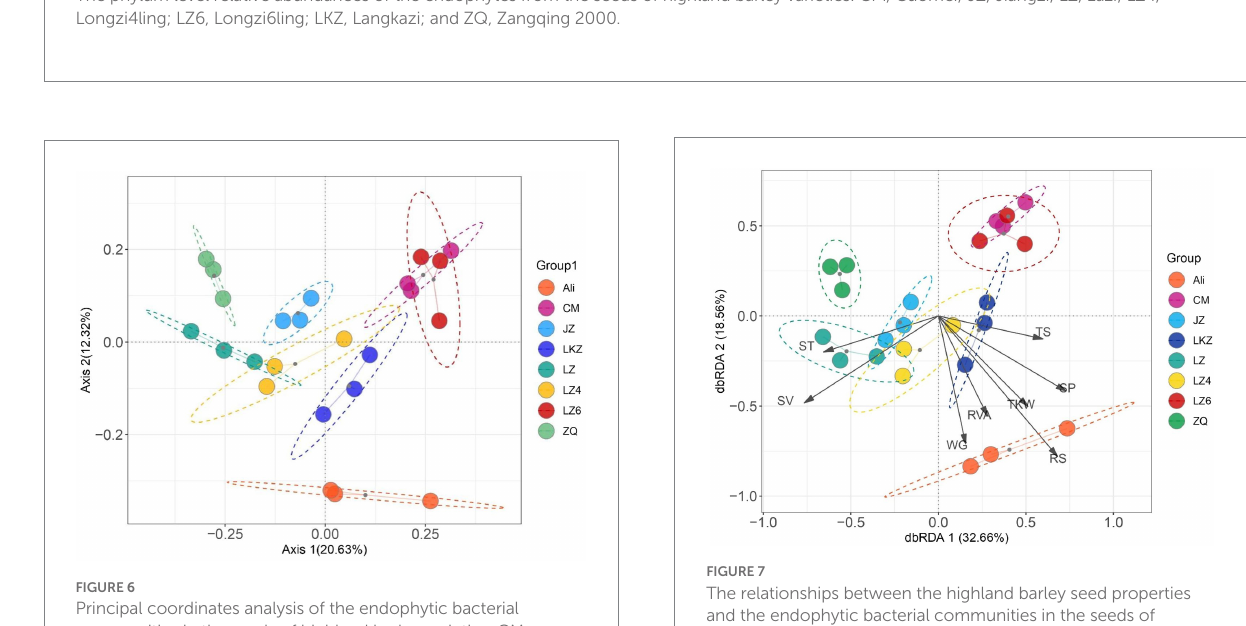
FIGURE 7 The relationships between the highland barley seed properties and the endophytic bacterial communities in the seeds of highland barley varieties. The abbreviations of highland barley varieties are as in Figure 1. AM, amylose content; TS, total sugars; RS, reducing sugars; WG, wet gluten; SV, sedimentation value; SP, soluble protein; RVA, viscosity; and TKW, 1000-kernel